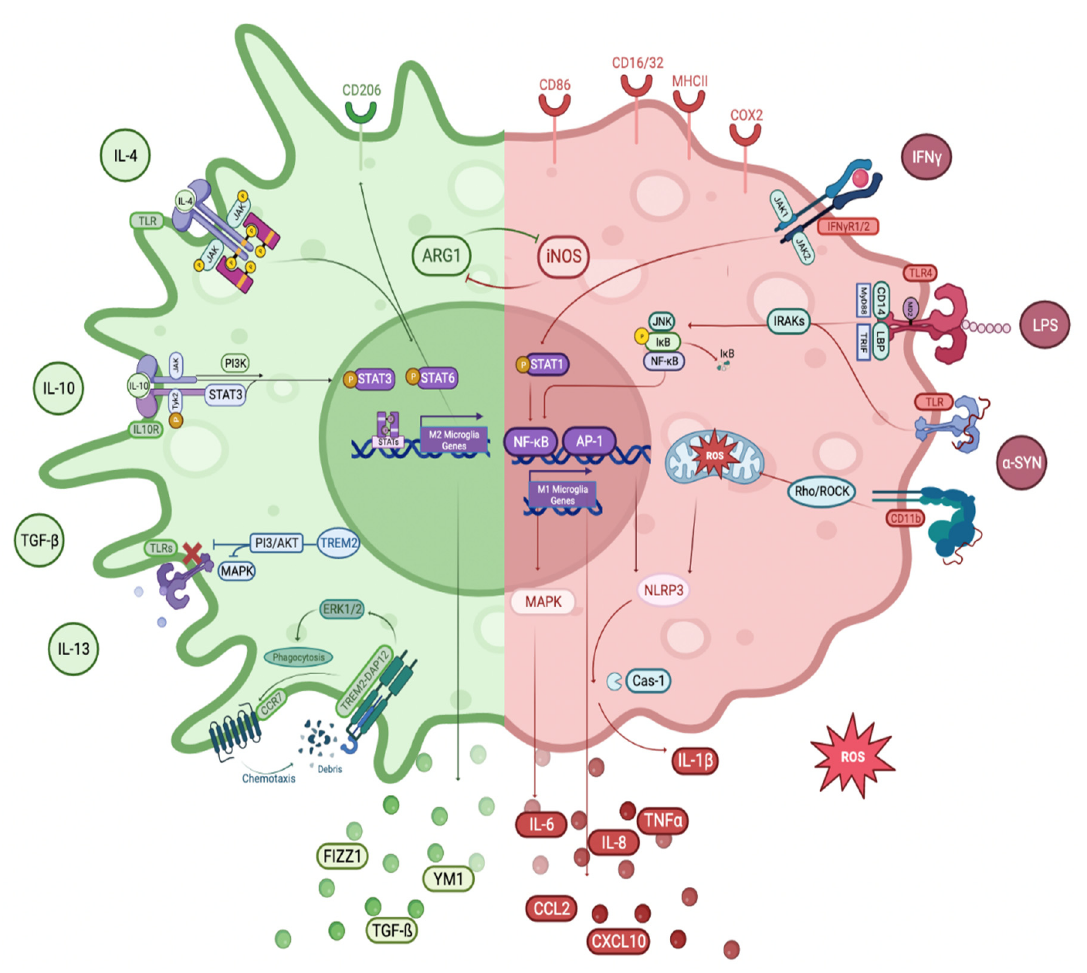
Figure 2. Overview of microglial M1 and M2 signaling pathways in PD. The right side of the figure represents the M1 microglial phenotype and its related signaling pathways. LPS, which is one of the main M1 microglia activators, binds to MD2 ‐ bound TLR4 on the cell surface via LBP (LPS ‐ binding protein) and CD14, which acts as a co ‐ receptor. The resulting complex binds to TRIF and Myd88 by interacting with the cytoplasmic domain of TLRs and individual TIR domains. Activated TLR phos ‐ phorylates the IKK complex, which consists of MAP kinases, such as IKK β , JNK, through autophos ‐ phorylation of IRAKs, thereby inducing translocation and activation of transcription factors NF ‐κ B and AP ‐ 1 and initiates upregulation of M1 ‐ associated gene transcription. M1 activation by IFN γ occurs by initiation of the signaling pathway by IFN γ R1/2, phosphorylation of STAT1 and inter ‐ feron regulatory factors, and translocation to the nucleus via JAK1/2. Aggregates of α‐ syn released into the extracellular space bind to TLR2 following the working mechanism of TLR2s, triggering activation of NF ‐ kB and subsequent NF ‐ kB ‐ dependent upregulation of NLRP3 and production of proinflammatory cytokines. NLRP3 activation provides caspase ‐ 1 ‐ mediated release of IL ‐ 1ß and IL ‐ 8. In addition, α‐ syn clusters are recognized by CD11b and induce mitochondrial ROS generation by impairing mitochondrial function via the Rho/ROCK pathway. In addition, the activation of the M1 phenotype contributes to the regulation of intracellular iNOS, cell surface markers (CD86, CD16/32, and MHC II), M1 ‐ related pro ‐ inflammatory cytokines (IL ‐ 1 β , IL ‐ 6, IL ‐ 12, IL ‐ 17, IL ‐ 18, IL ‐ 23, and TNF α ), and chemokines (CCL2, CXCL10). The left side of the figure represents the M2 mi ‐ croglial phenotype and its related signaling pathways. M2 status is mainly induced by anti ‐ inflam ‐ matory stimuli, such as IL ‐ 4, IL ‐ 10, IL ‐ 13, TGF ‐β , and glucocorticoids. IL ‐ 4 binds to IL ‐ 4R causing phosphorylation of JAKs/STAT6 and translocation of STAT6 to the nucleus. Activated STAT6 spe ‐ cifically leads to the transcription of M2 ‐ related genes, including intracellular components, such as CD206 and cytokine signal suppressor 3 (SOCS3). IL ‐ 10 binds to IL ‐ 10R1/2, enabling STAT3 to be phosphorylated and translocated to the nucleus via the JAK/STAT signal cascade and PI3K. STAT3 translocation inhibits M1 ‐ related proinflammatory cytokines and upregulation of IL ‐ 10 and TGF ‐β .